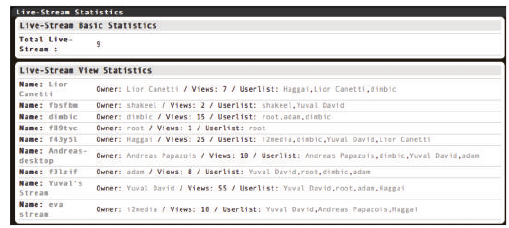
Figure 13: Live video streams’ monitoring on the web